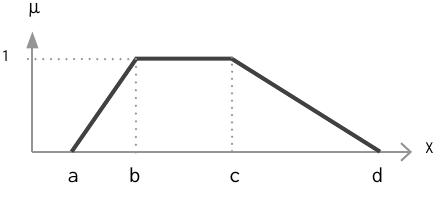
Fig. 1. Trapezoidal fuzzy number; < a , b , c , d